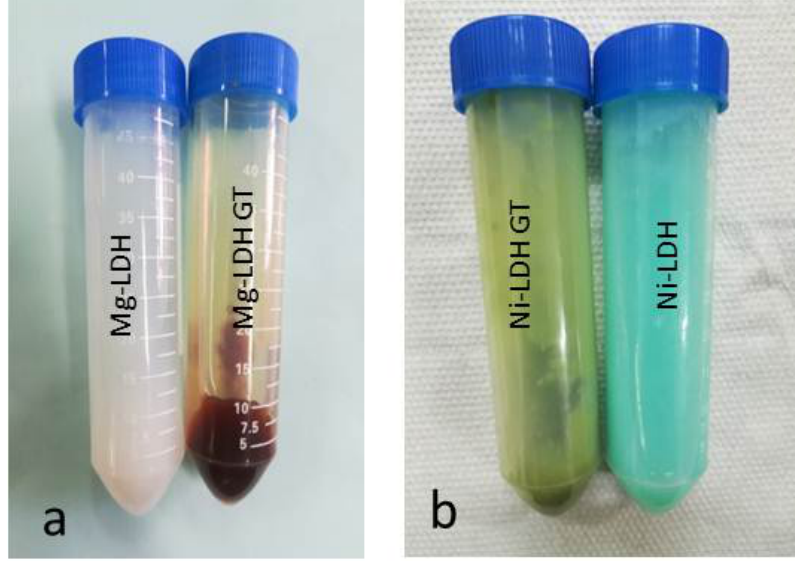
Figure 2. ( a ) MgAl-LDH and MgAl-LDH loaded green tea, ( b ) NiAl-LDH and NiAl-LDH intercalated green tea interlayer structure.